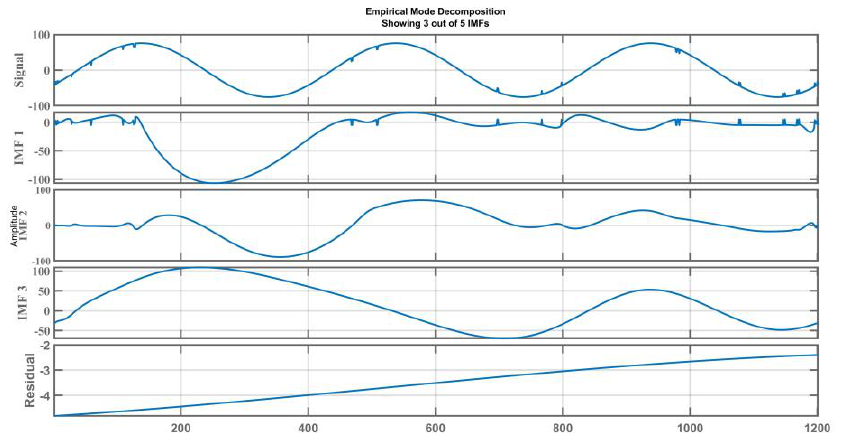
Figure 11. 3 layers of decomposition.